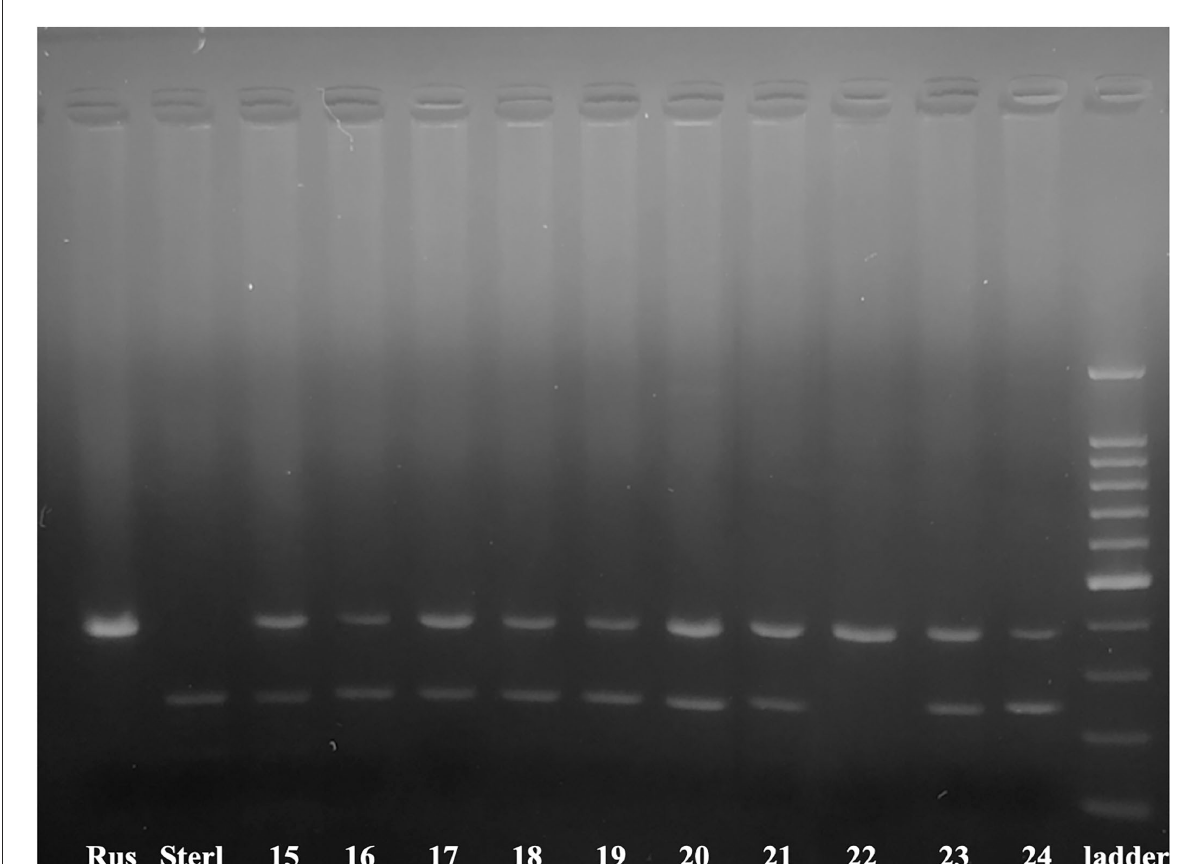
FIGURE2 Electrophoretogram of 395_AB and 247_AR markers in 10 ICSI produced transplants. The marker 395_AB amplifies 395 bp band only when a sample contains Siberian and/or Russian sturgeon nuclear DNA and the marker 247_AR amplifies 247 bp band only when a sample contains nuclear DNA of sterlet. Numbers correspond to the embryos and larvae of Table 2. Russian sturgeon fin (Rus) and sterlet fin (Sterl) are positive controls 100–1500 bp